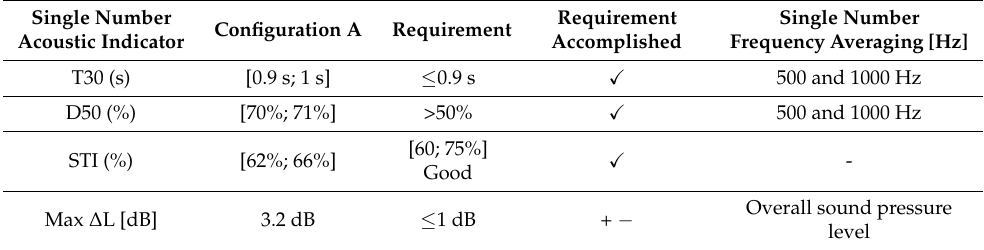
Table 9. Single number acoustic indicators for the auditorium with configuration A.